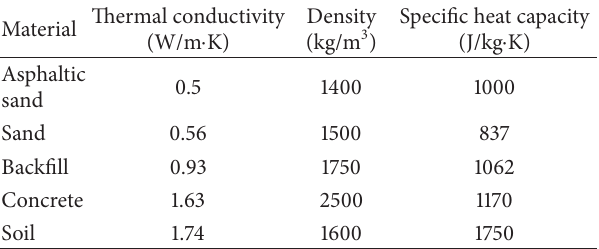
Table 1: Physical properties of different materials. Thermal conductivity Material (W/m ⋅ K)